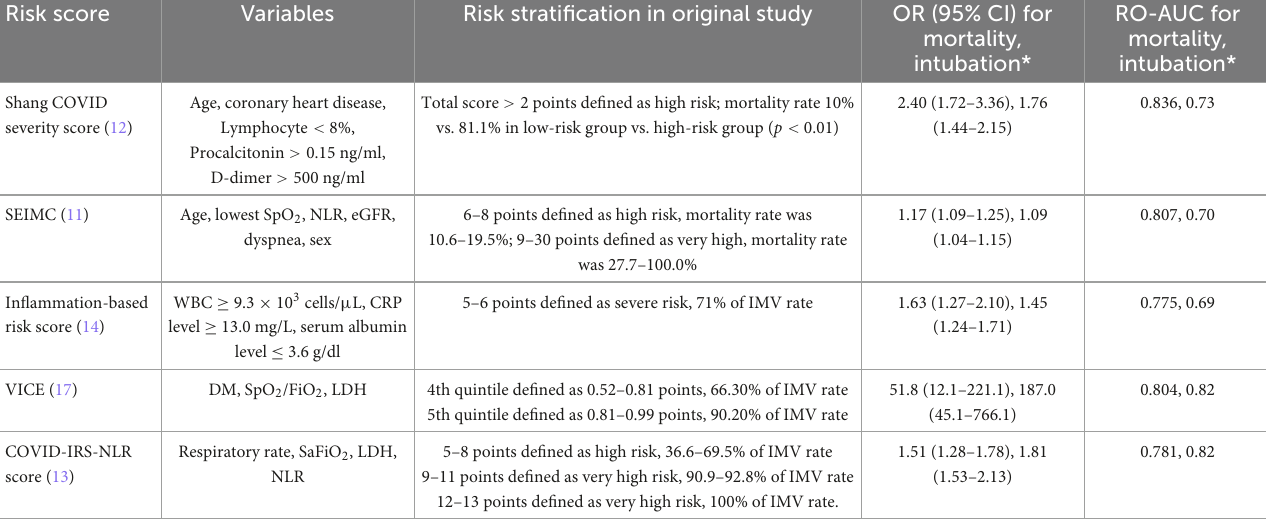
RO-AUC for mortality, mortality, intubation*